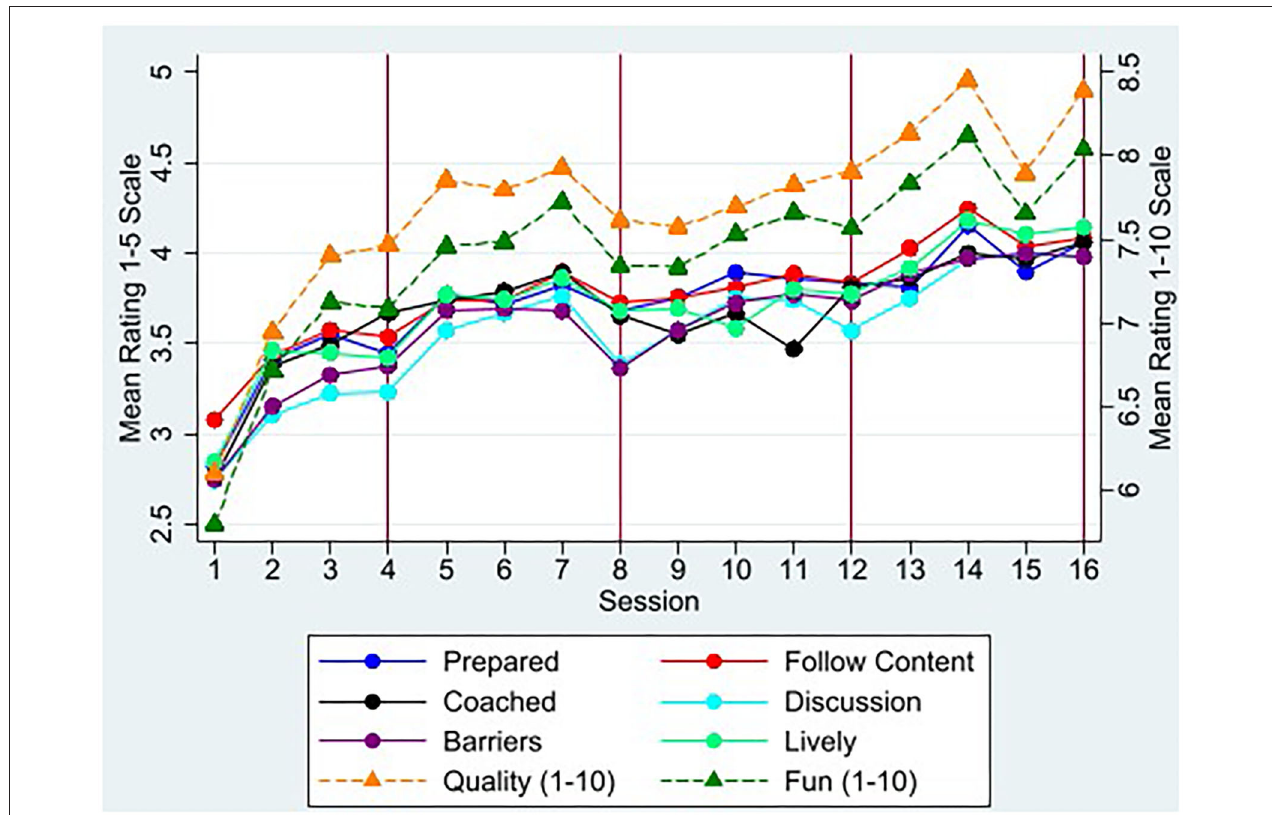
FIGURE 2 | Mean CHV Delivery Scores by Session. Figure plots mean scores from supervisor monitoring forms across all CHVs by session for items measured on a 1–5 scale from “poor” to “excellent” for six of 13 delivery measures using solid lines. N = 686 supervisor rating forms across 16 sessions and 40 villages. Some earlier sessions had more than 1 supervisor present. For session “quality” and “fun,” figure plots mean scores on 1–10 scale on right-hand-side axis using dashed lines. All 13 delivery measures show similar upward trends and the full list is in Figure 3 . Red vertical lines represent review sessions when sessions were home visits for mixed-delivery arm and group sessions for group-only